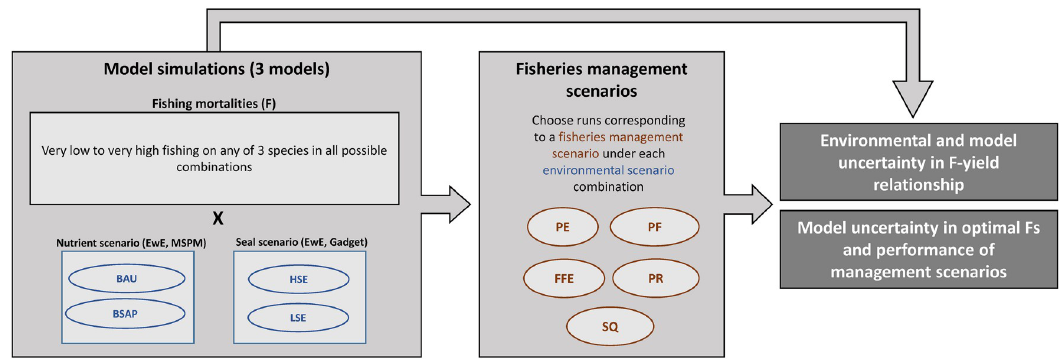
Fig 2. Summary of the framework. Light shaded rectangles describe the main steps of the modelling work, dark shaded rectangles indicate scientific products potentially useful for ecosystem-based fisheries management. See Table 2 for description of alternative fisheries management scenarios and Methods for the definition of nutrient and seal scenarios.